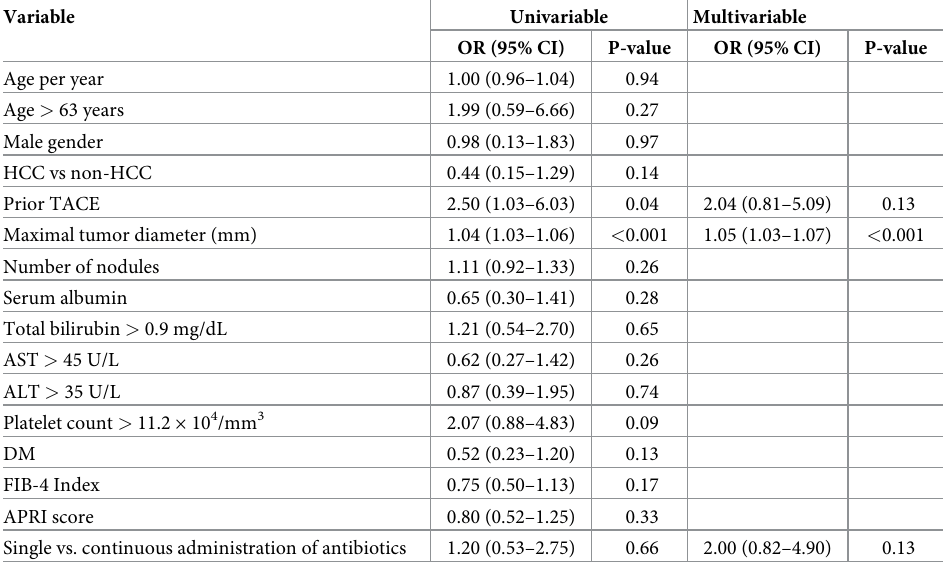
Table 3. Univariable and multivariable analyses of infectious